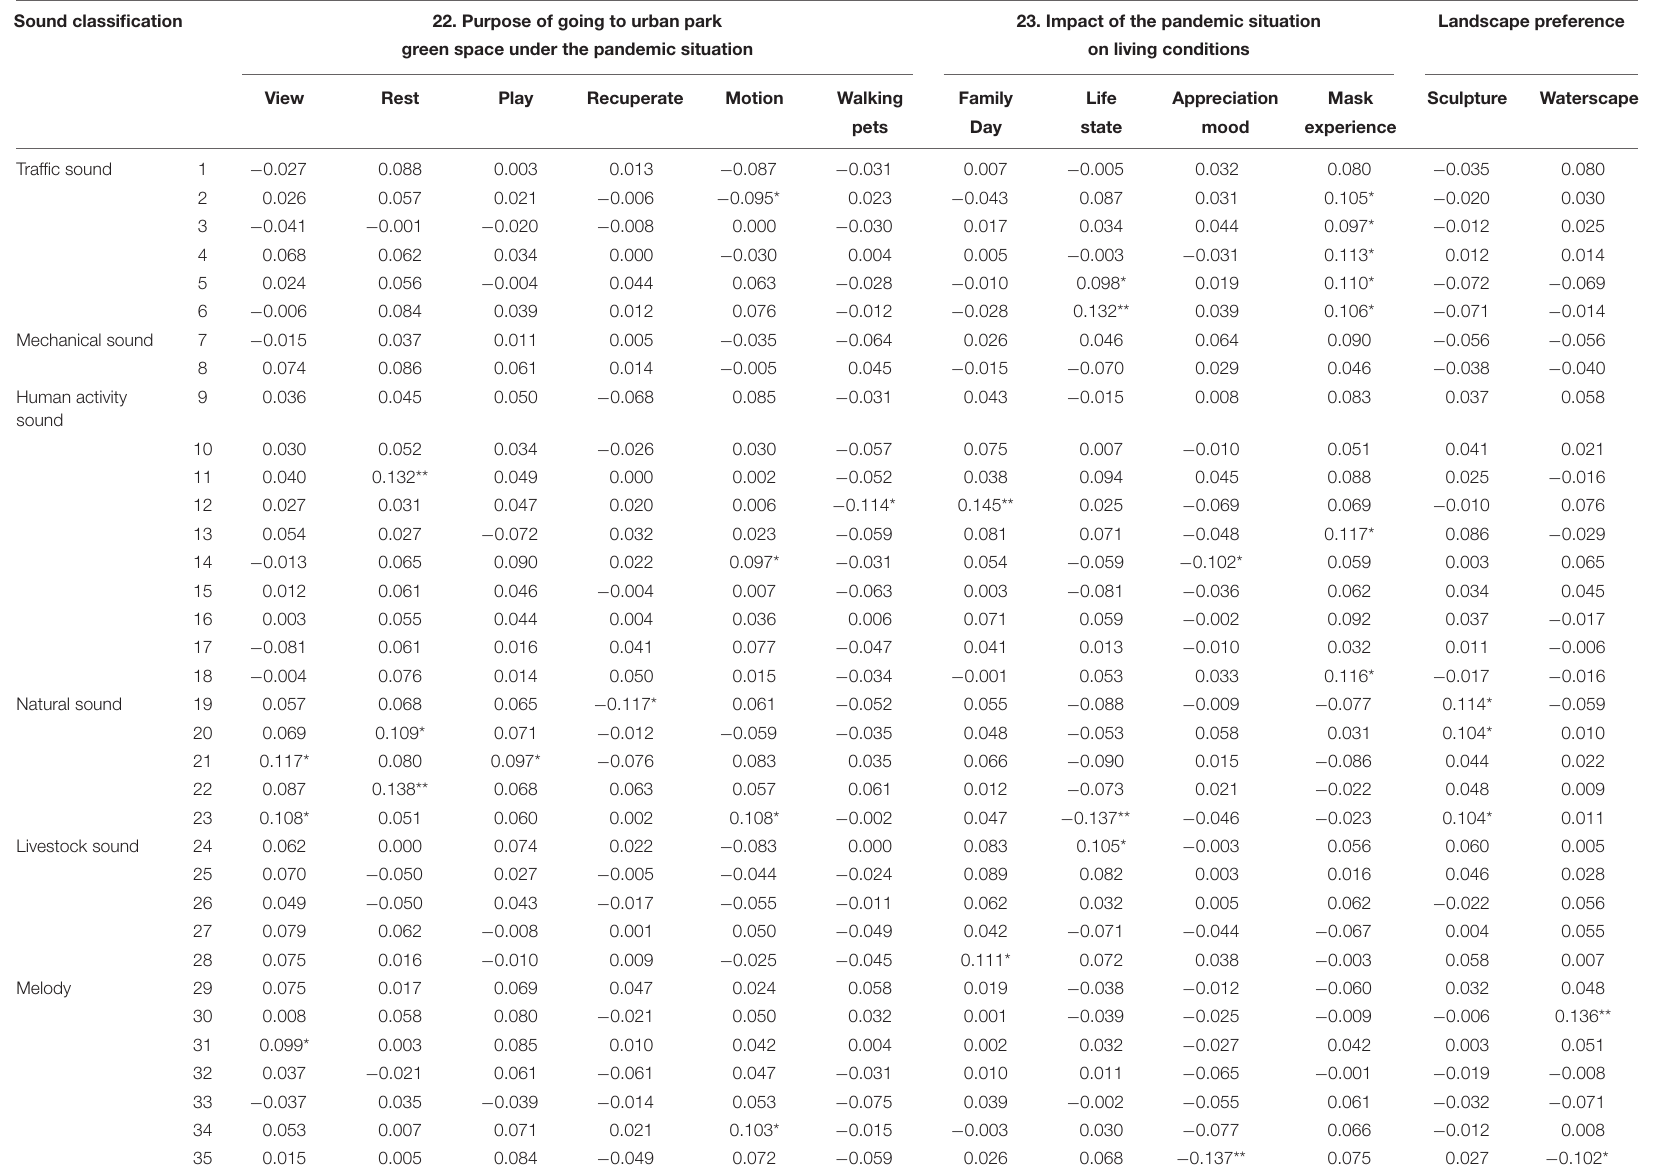
TABLE 2 | Correlation between public landscape space preference and soundscape preference under pandemic situation (code is shown in Table 1 ). Sound